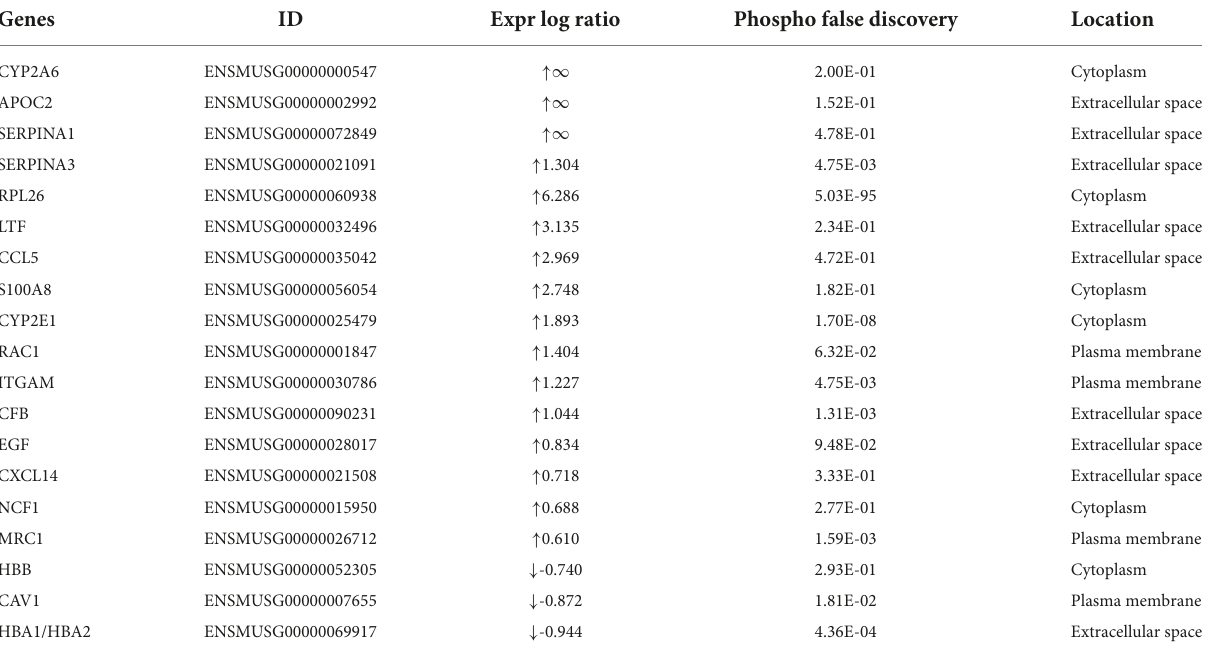
TABLE 2 IPA analysis identifies increase of synthesis of reactive oxygen species in MYH6-Cre-BDNF − / − heart (activation z -score = 2.418; p = 6.05E-06). Genes ID Expr log ratio Phospho false discovery